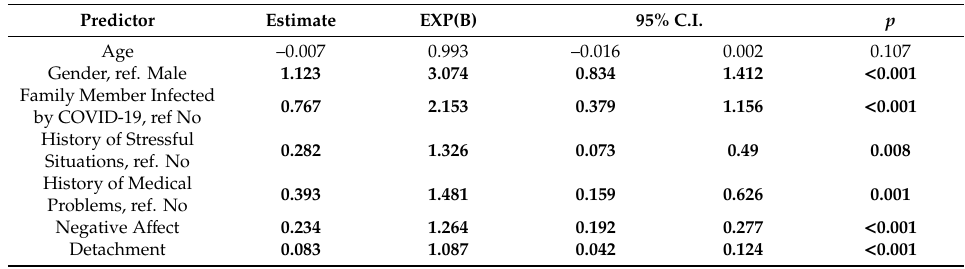
Table 5. Association between significant sociodemographic variables, personality traits, and DASS-21 anxiety during the COVID-19 outbreak ( n = 2766).